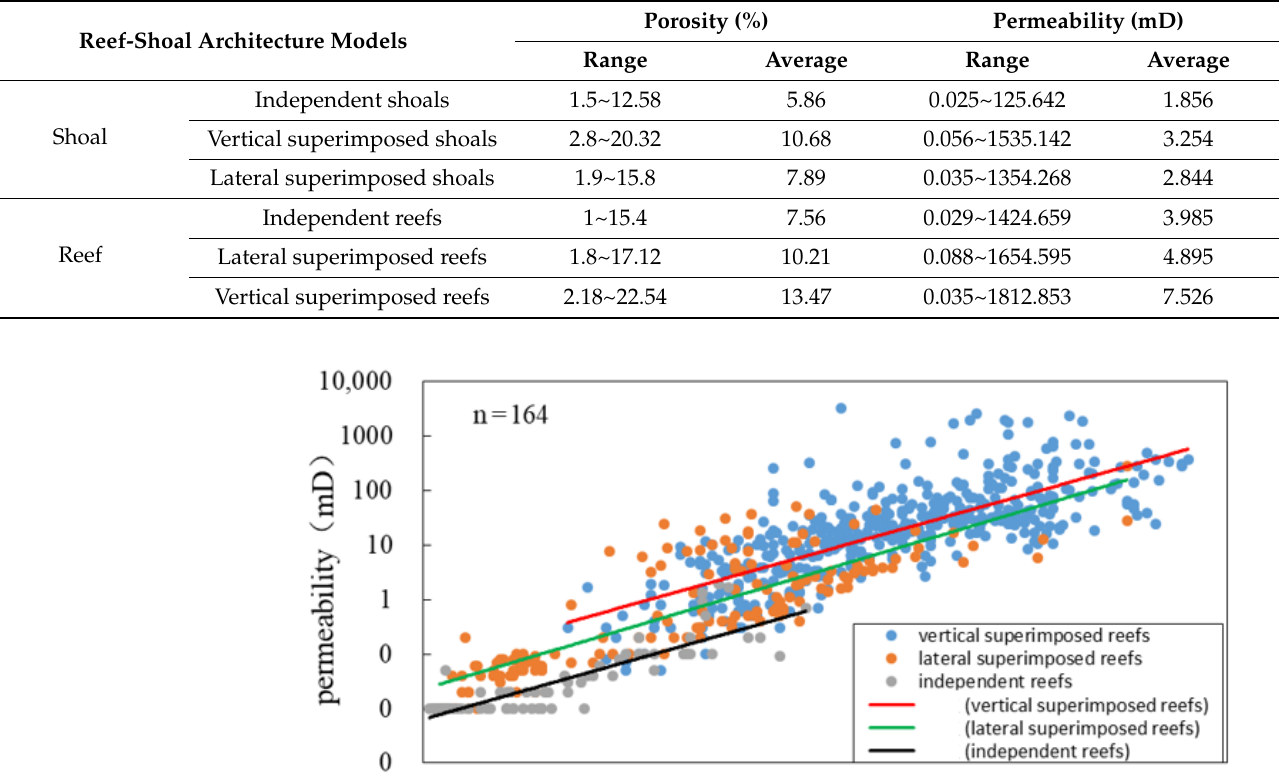
Table 4. Statistical table of physical property data of reservoirs corresponding to different types of reef and shoal architectures.